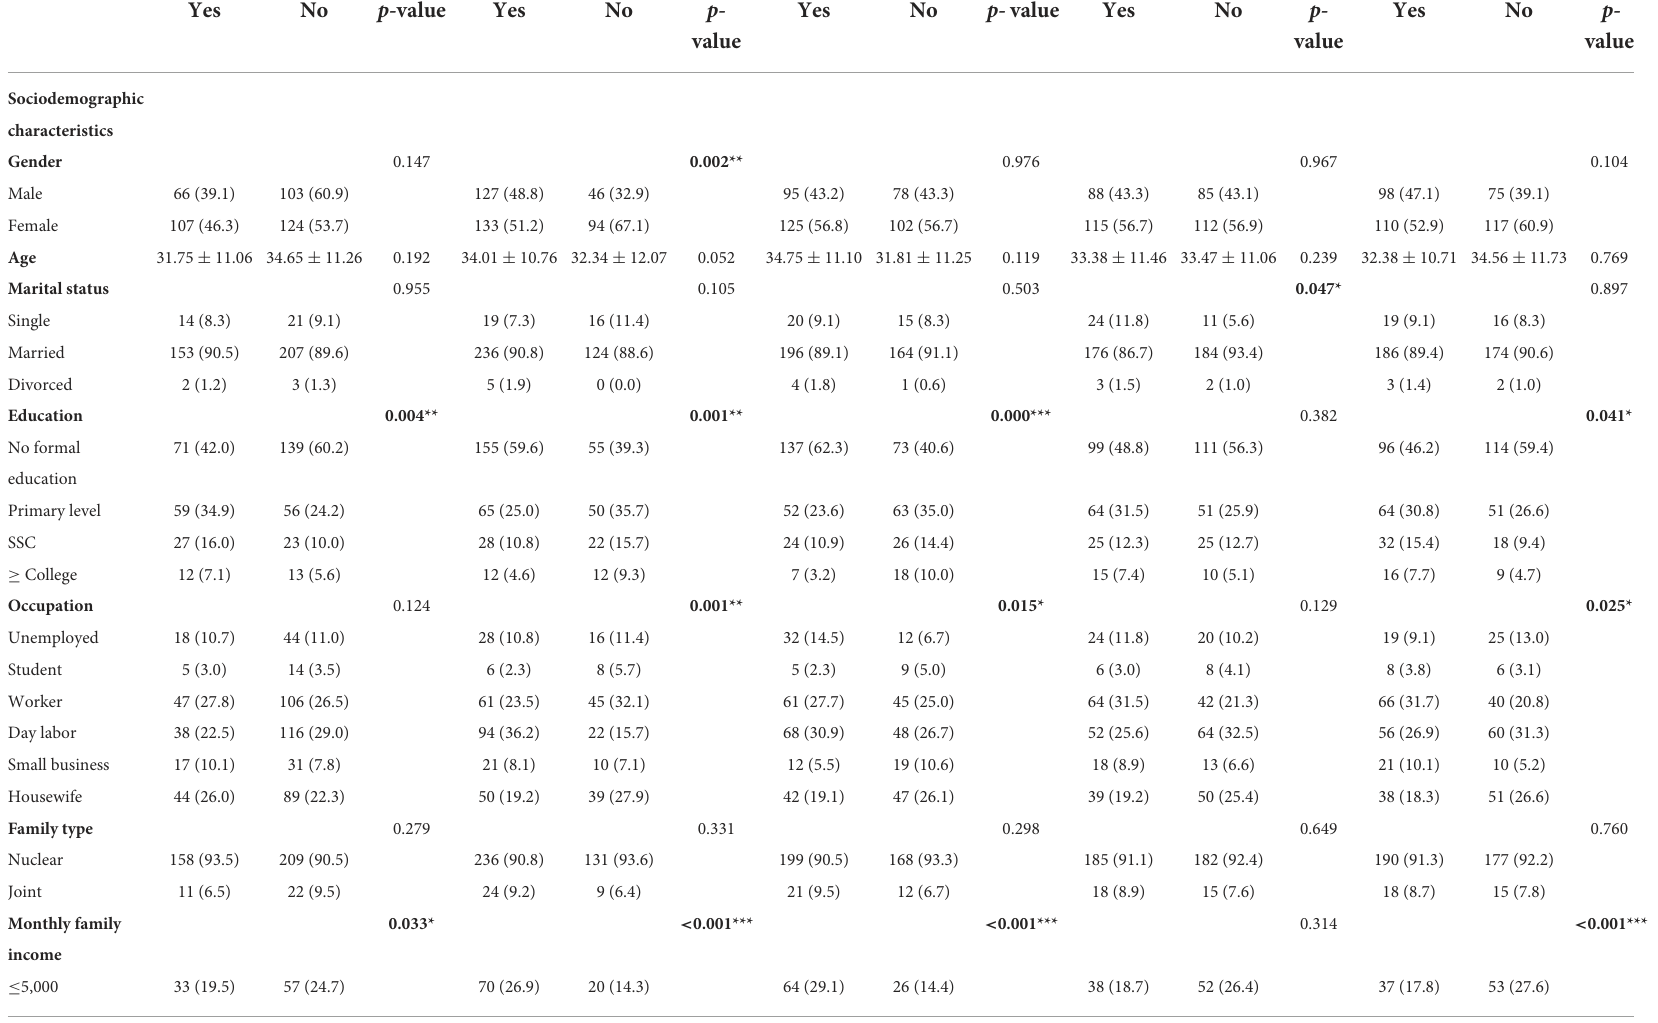
TABLE 2 Univariate analysis of 5C